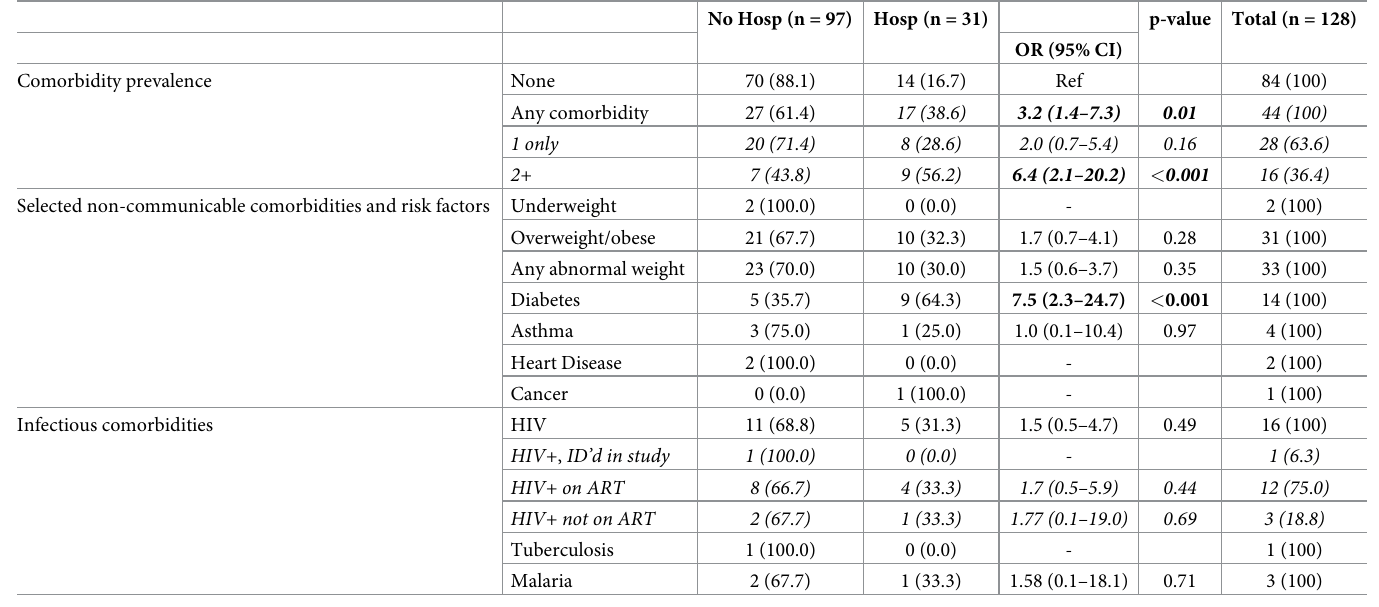
Table 3. Comorbidity and disease severity in adults aged � 25 years, FFX study, Kisumu, Kenya (June-October 2020).